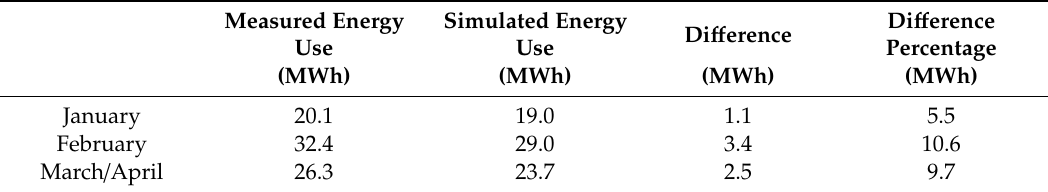
Table 7. Monthly measured and simulated energy to the hydronic radiators, including the di ff erence in energy and percentage during the occupied validation